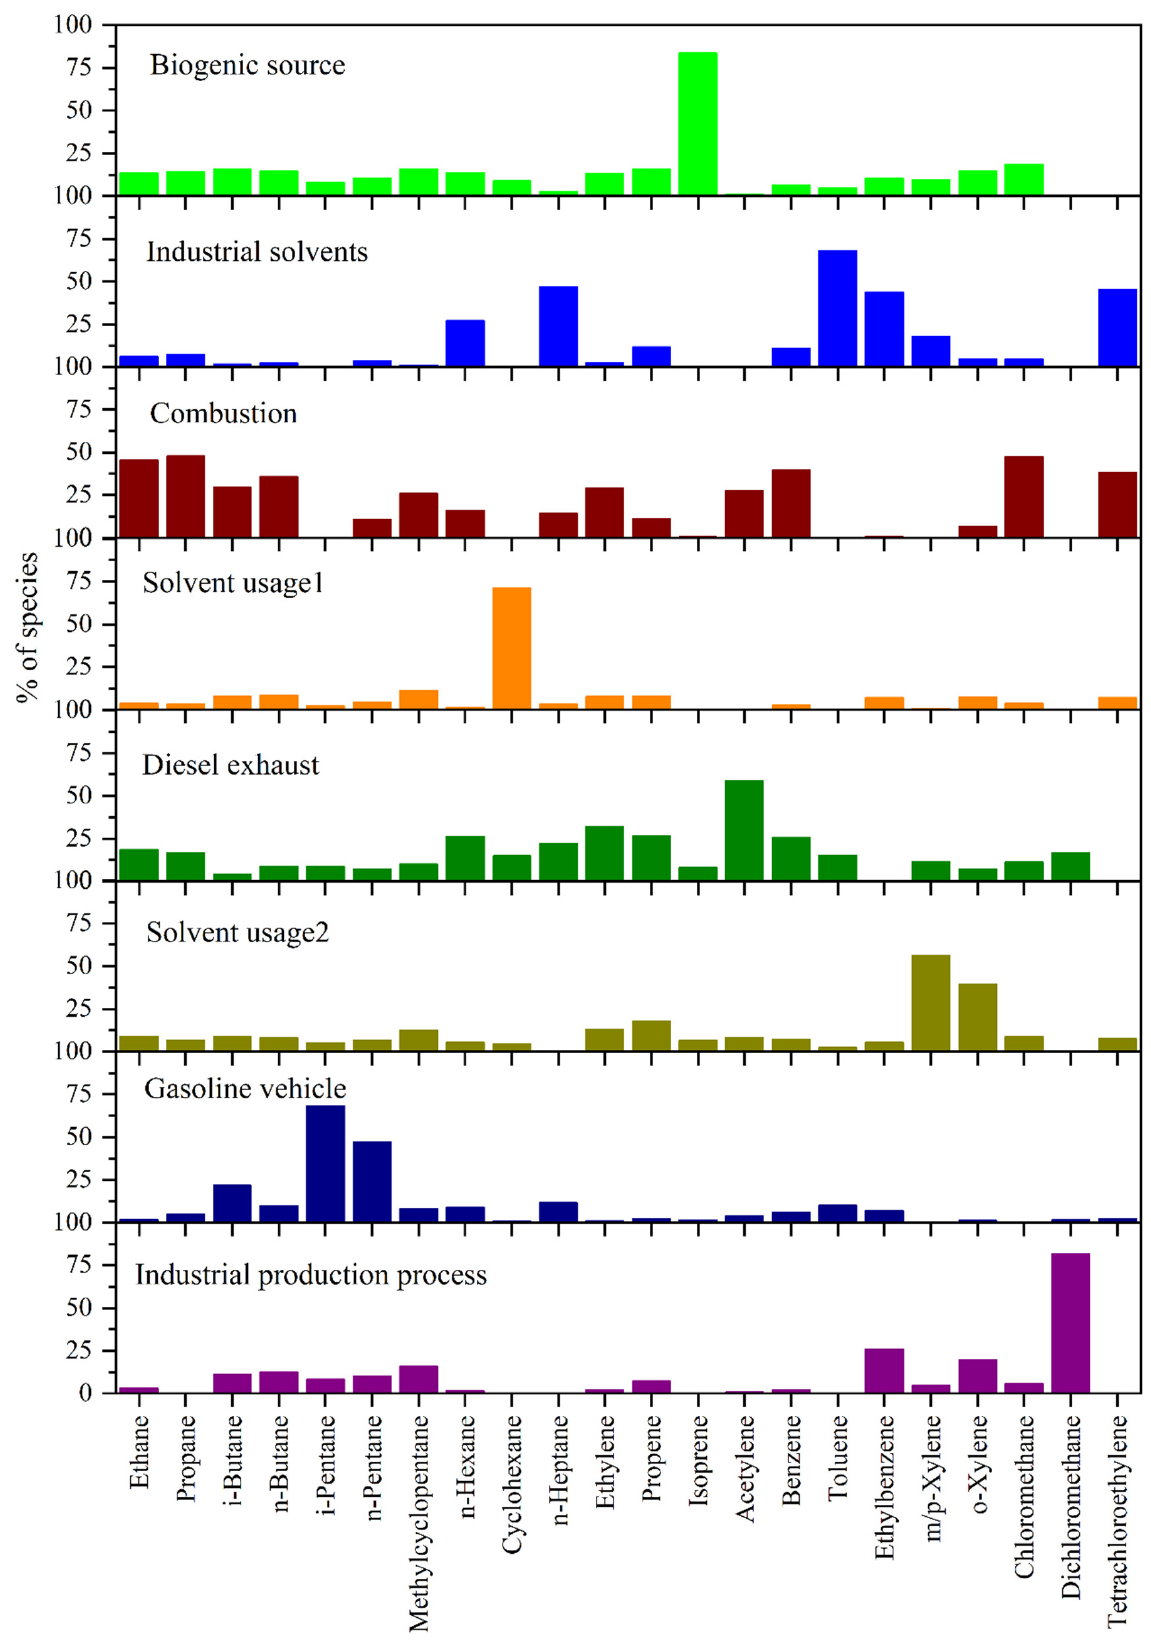
Figure 5. Source profiles (percentage of factor total) resolved from PMF in Xinxiang.